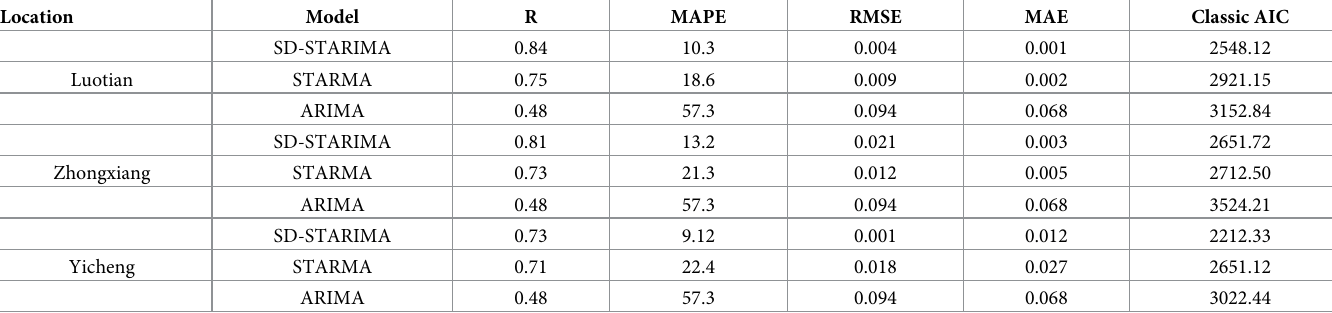
Table 10. Results for both fit and general prediction performance for the ARIMA, STARIMA and SD-STARIMA models.